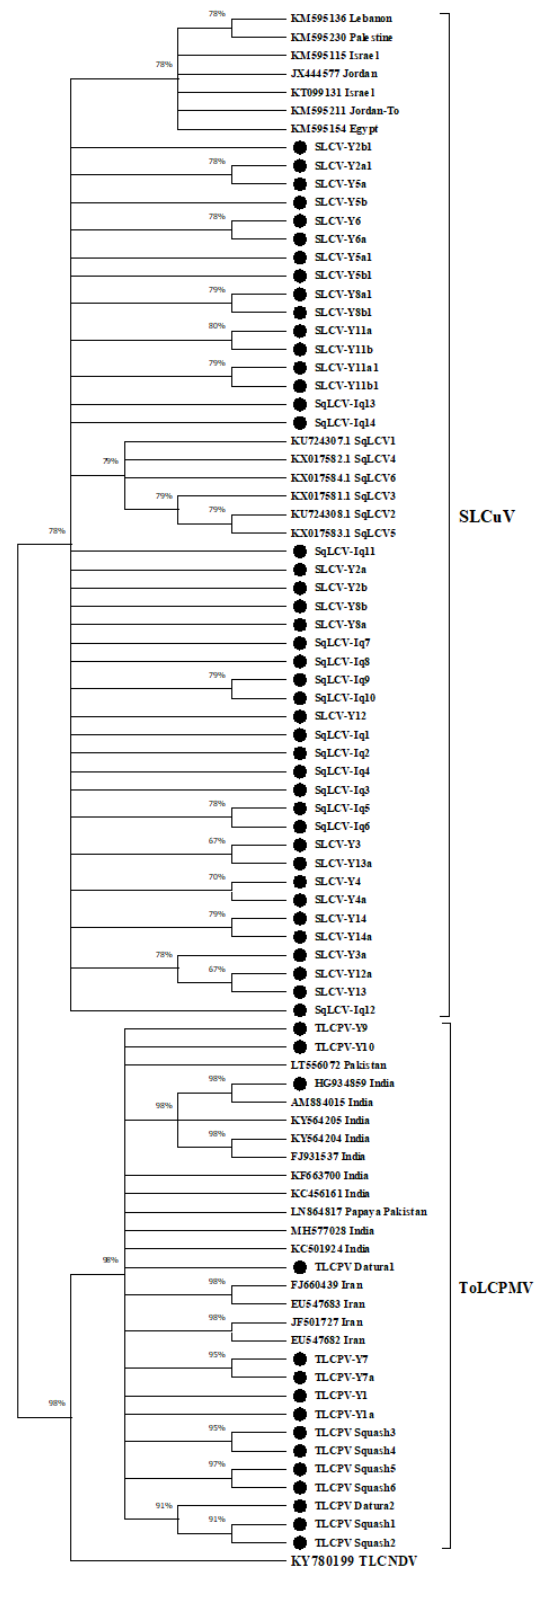
Figure 5. Neighbor joining phylogenetic tree constructed from partial begomoviral CP nucleotide sequences of SLCuV and ToLCPMV isolates from Iraq (marked with ● ) and equivalent GenBank sequences. Tomato leaf curl New Delhi virus TLCNDV was used as an out-group